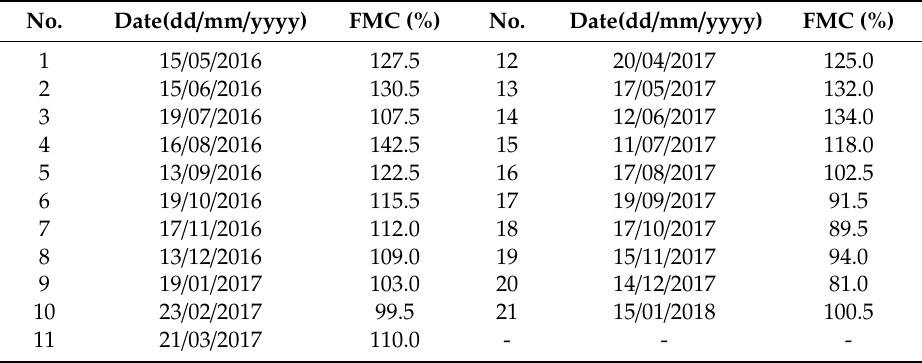
Table A1. The time-series field FMC measurements in CNTX_McCl_TX